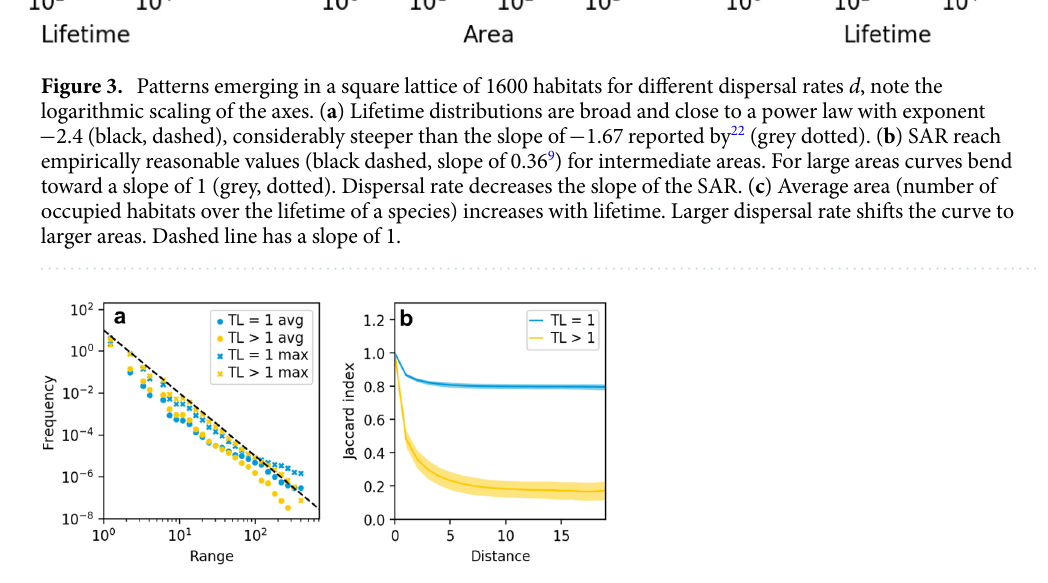
Figure 4. Range distribution and similarity decay with distance in a system with 400 habitats and a dispersal rate of 10. ( a ) Distribution of maximum and average range for the basal layer (TL1) and all other species (> TL1). Average range refers to the average number of habitats a species occupied during its lifetime. Dashed line has a slope of − 3, so most species have small ranges. ( b ) Food web similarity, measured by the Jaccard index for the same simulation as in ( a ), error bars denote standard deviation from the mean (for calculation see “Model and methods”). Similarity decreases with distance. The decrease is small for the basal layer, but steep for the higher trophic